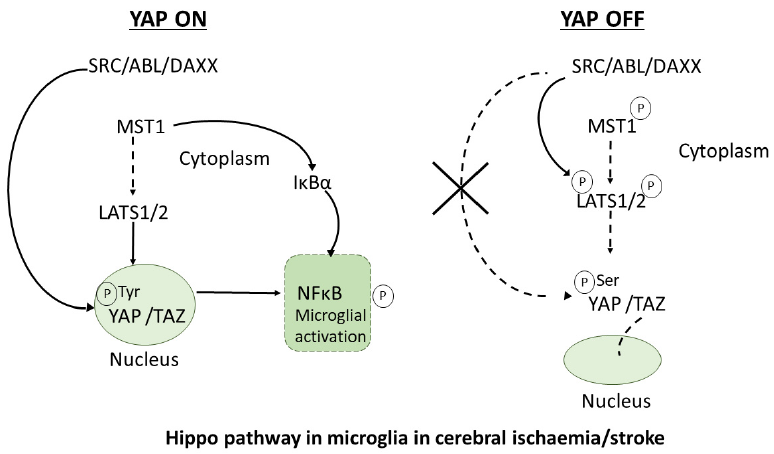
Figure 2. Hippo pathway components that are known to function in microglia under cerebral ischaemia or stroke conditions (see Section 4.2). On YAP activation by phosphorylation at tyrosine (Tyr) residues (‘YAP ON’), YAP translocates to the nucleus to initiate specific gene transcription. On YAP inactivation (phosphorylation at serine (Ser) residues), YAP translocates to the cytoplasm (‘YAP OFF’). Phosphorylation (P) at the relevant residues by the upstream kinase is indicated by arrowed lines. Solid lines indicate experimentally proven pathways. Dotted lines indicate potential or likely pathways that have not yet been shown experimentally. Components in the nuclear and cytoplasmic components are labelled.